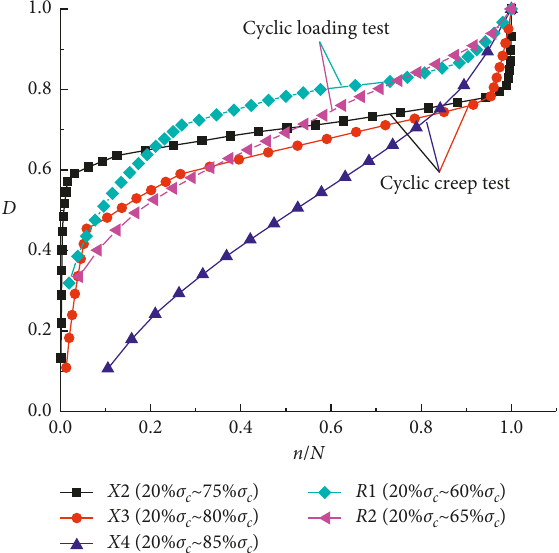
Figure 8: Evolution curve of damage variable under different maximum